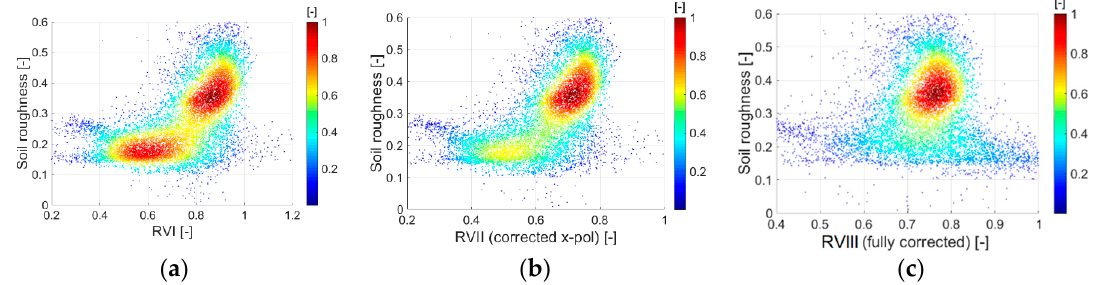
Figure 11. Correlation for the combined study areas between: ( a ) RVI [-]; ( b ) x-pol corrected RVII [-]; ( c ) fully corrected RVIII [-] and SMOS-based soil surface roughness ( ks ) [-] (derived from Parrens et al. from [19]).